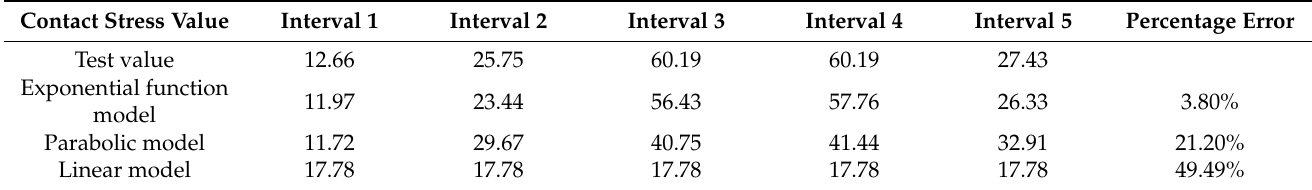
Table 2. Error comparison between different models and experimental stress values (N/cm 2 ) ( λ = 18.75).